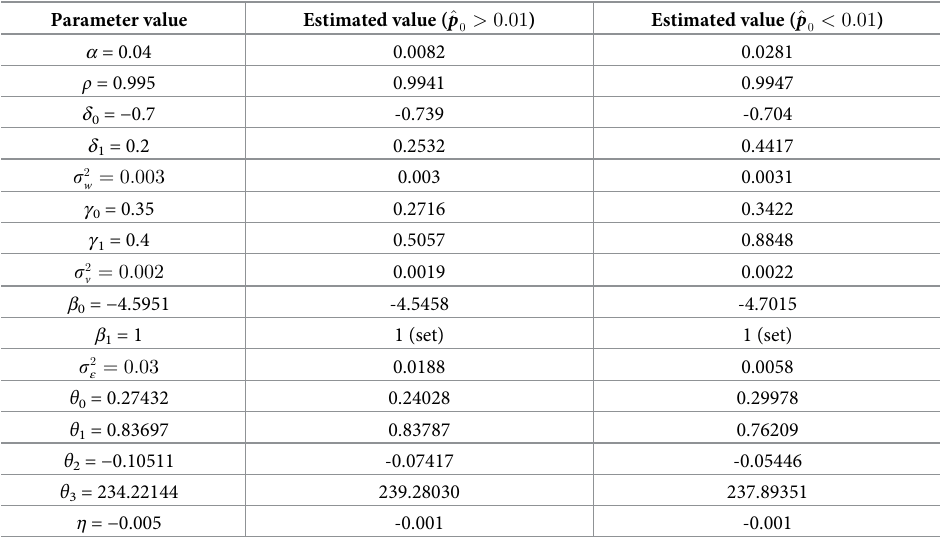
Table 2. Parameter estimation with simulated